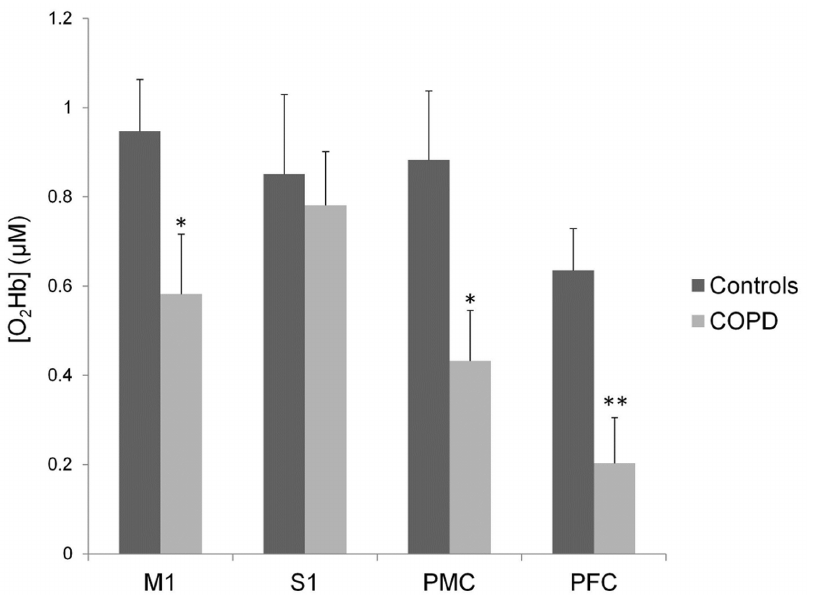
Figure 3. HbO changes during maximal voluntary contractions over primary motor (M1), primary sensory (S1), premotor (PMC) and prefrontal (PFC) cortex areas. * p , 0.05 and ** p , 0.01 significantly different from